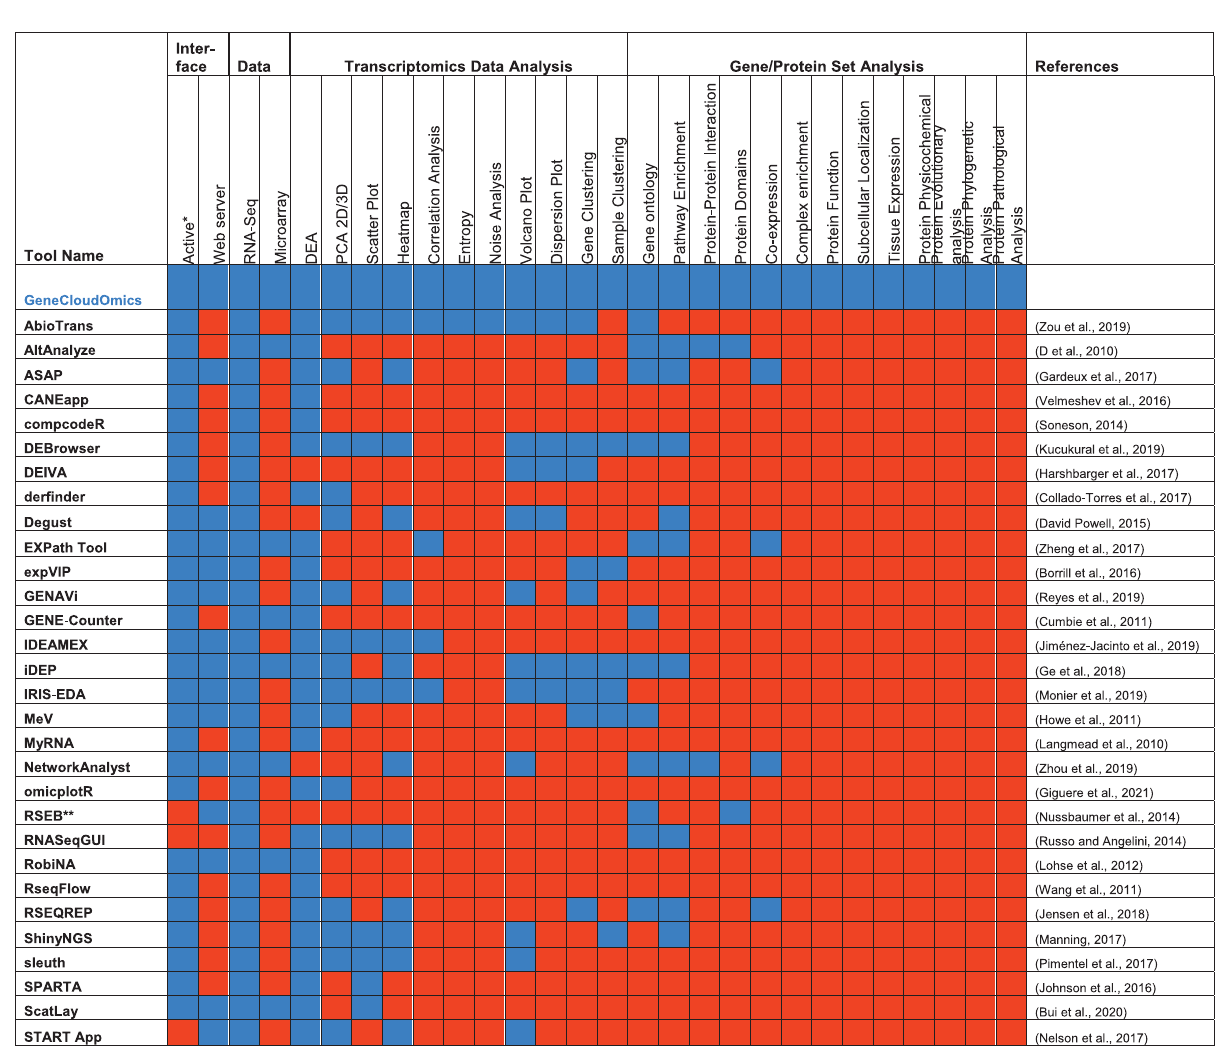
TABLE 1 | Comparison between 30 different gene expression analysis